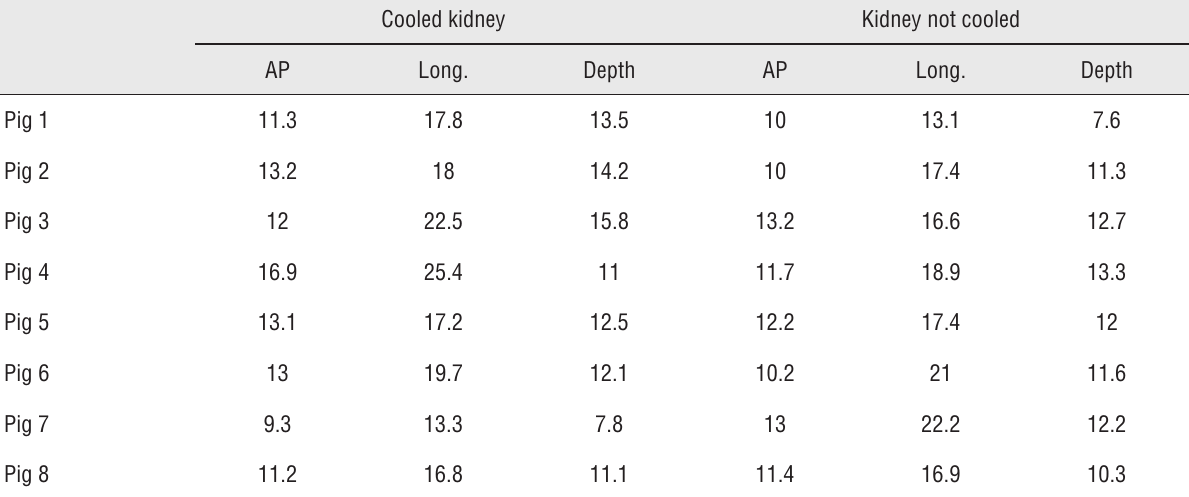
Table 3 - Size of the lesions in each animal (mm).